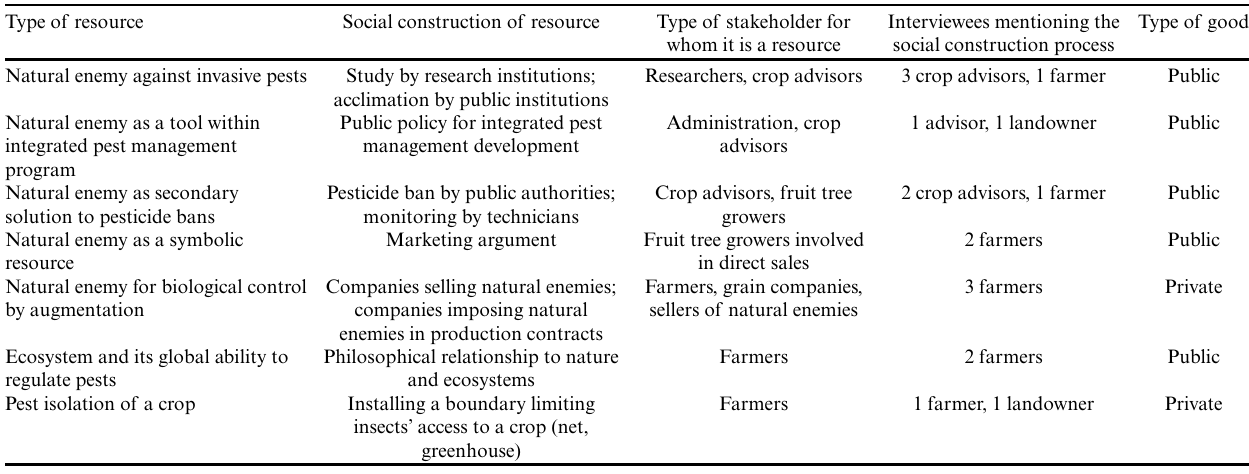
Table 2. Overview of social construction of resources